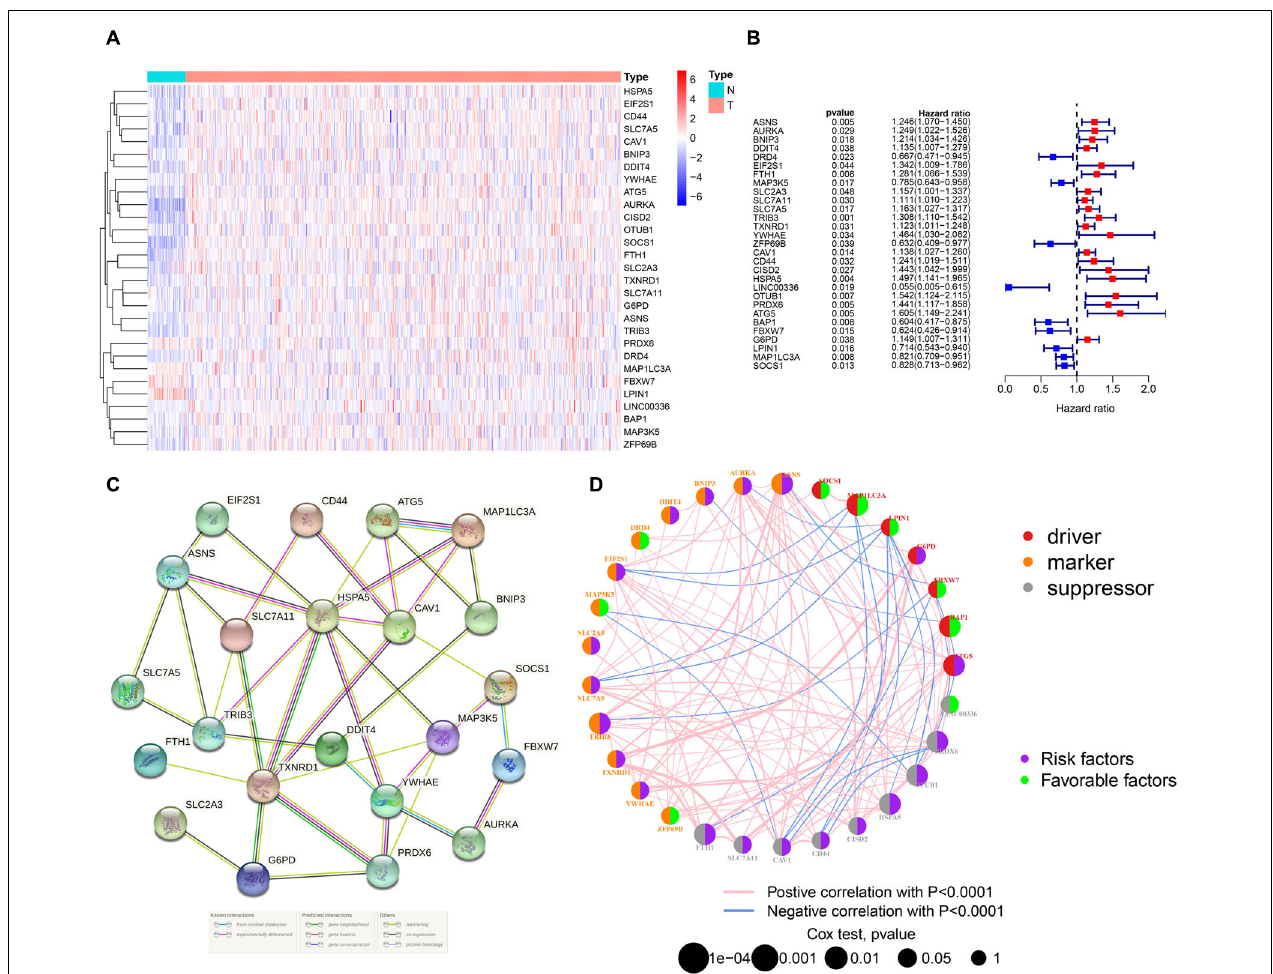
FIGURE 3 | Identification of PR-DE-FRGs used to construct association networks. (A) The heatmap used to show the expression profile of 29 PR-DE-FRGs. (B) The forest plot used to show the results of univariate Cox regression analysis between 29 PR-DE-FRGs and survival. (C) PPI of 29 PR-DE-FRGs. The bottom of the figure shows that the different colored lines between nodes represent different sources of evidence. (D) Correlation network of 29 PR-DE-FRGs. The left and right halves of the circle represent the attributes of the gene and its influence on the prognosis,